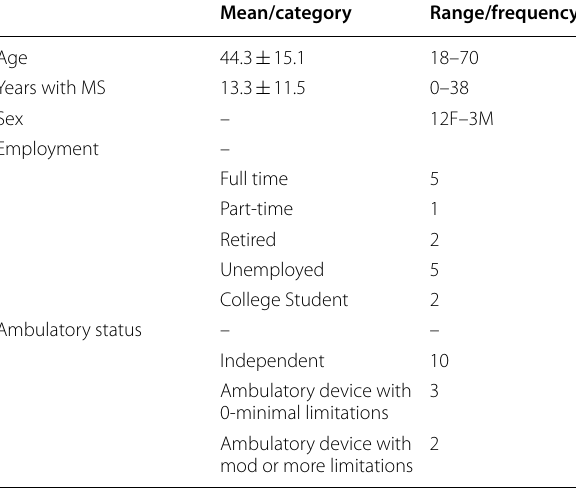
Table 1 demographic data for study participants (n